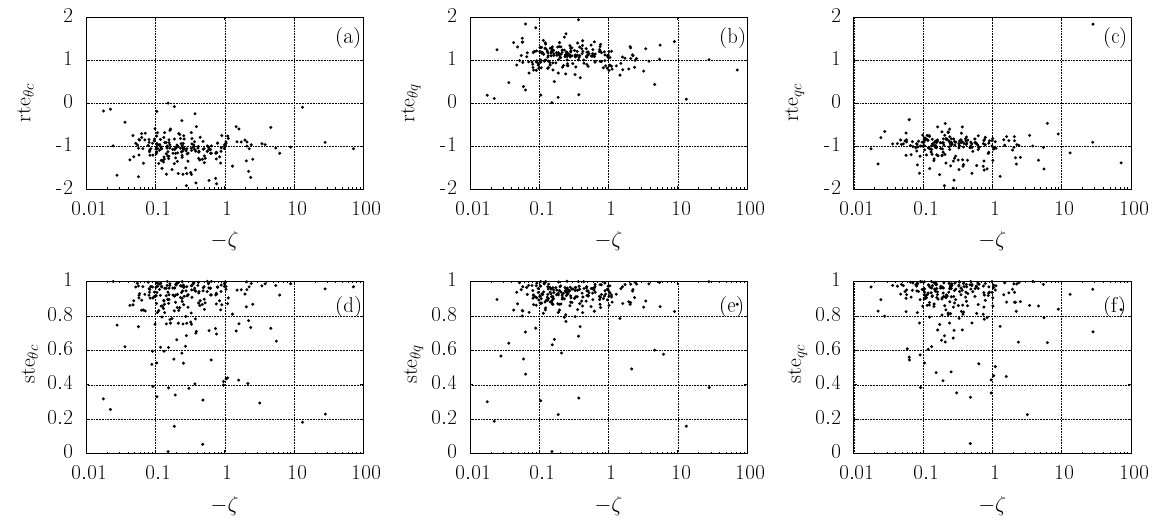
Figure 8. Scalar flux similarity indices rte (above) and ste (below) for 20 ◦ < | Z |≤ 60 ◦ : θ – c (a, d) ; θ – q (b, e) ; and q – c (c, f) . For rte, some data points were off the